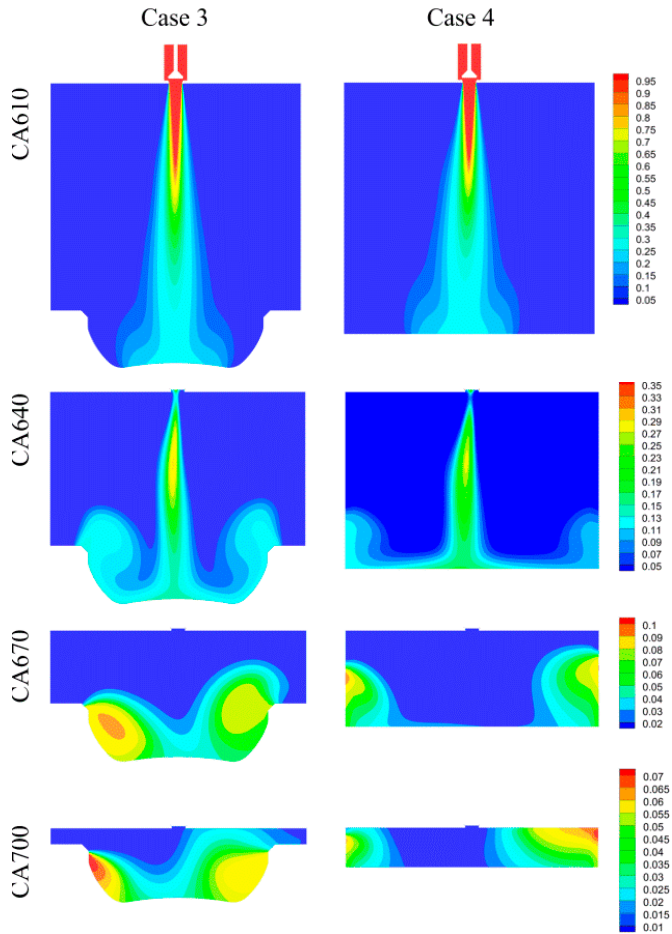
Figure 6. Comparison of the in-cylinder methane mass fraction distribution between Case 3 and Case